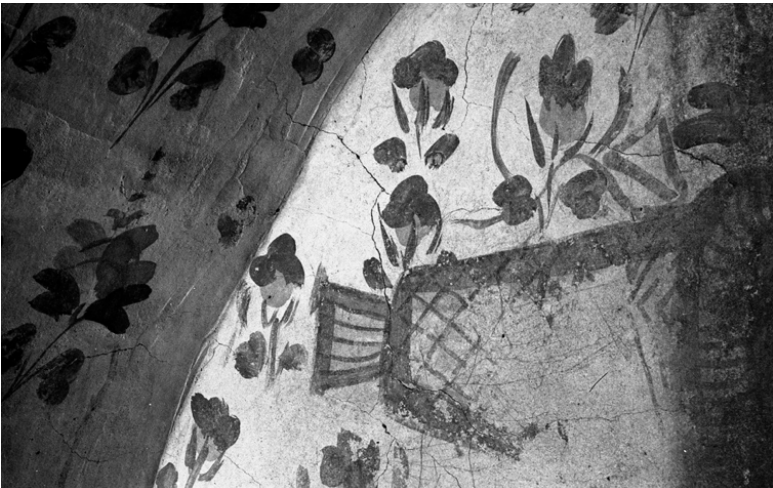
Figure A2. Sardis, “Peacock tomb” (Tomb 61.14, Appendix A.3), detail of northeast corner. © Archaeological Exploration of Sardis/President and fellows of Harvard College.